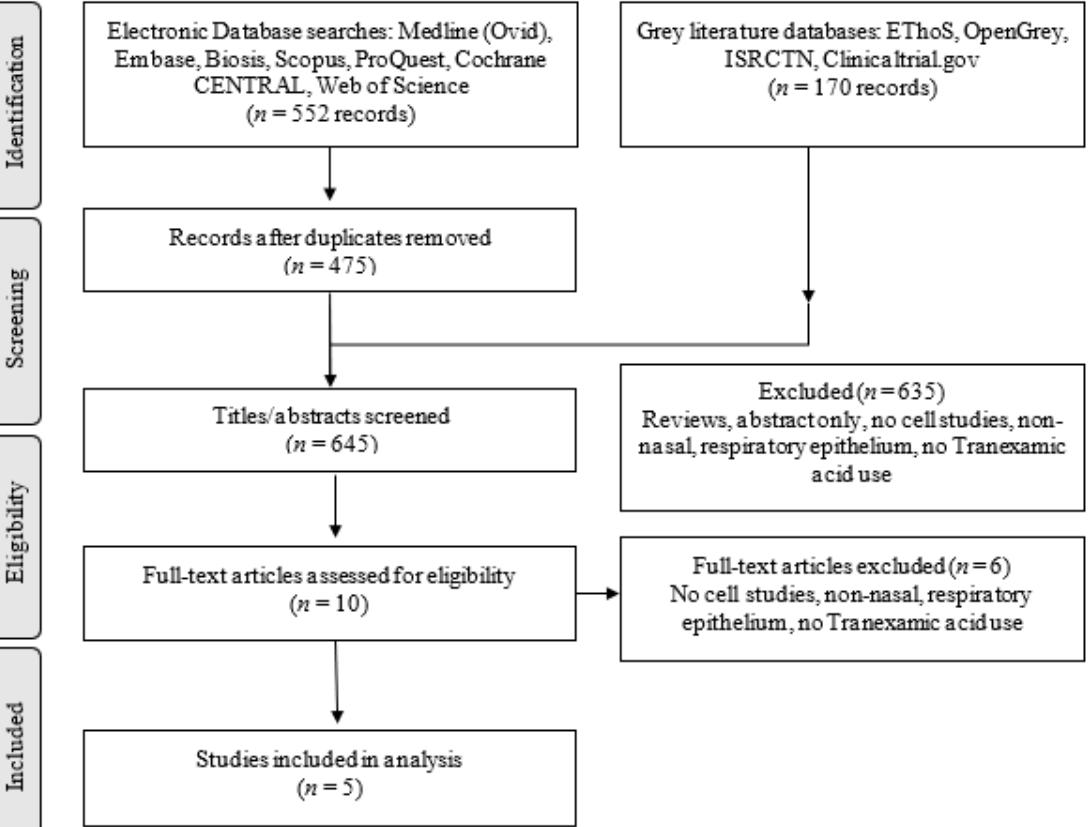
Figure 1. Prisma Flow Diagram [17]—scoping review. Table 1. Characteristics of included studies—scoping review.